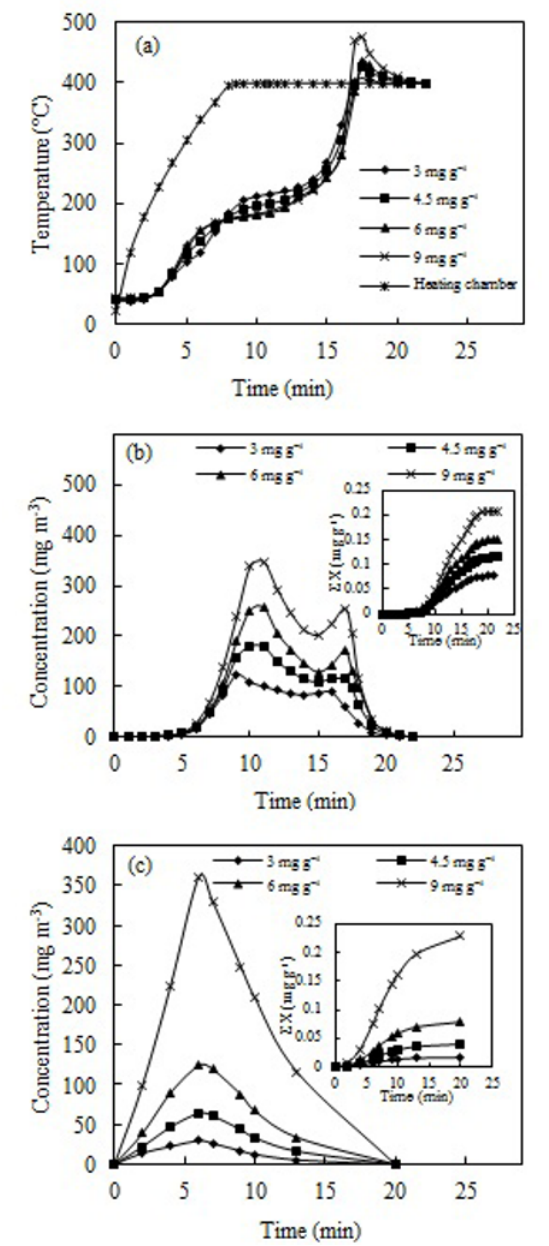
Figure 5. Temperature swing oxidation of o-xylene at different regenerative air flow rates: (a) temperature profiles of reactor and heating chamber; (b) evolution of CO; (c) thermal runaway of toluene; insets - integral amounts ( Σ X) of desorbed/formed